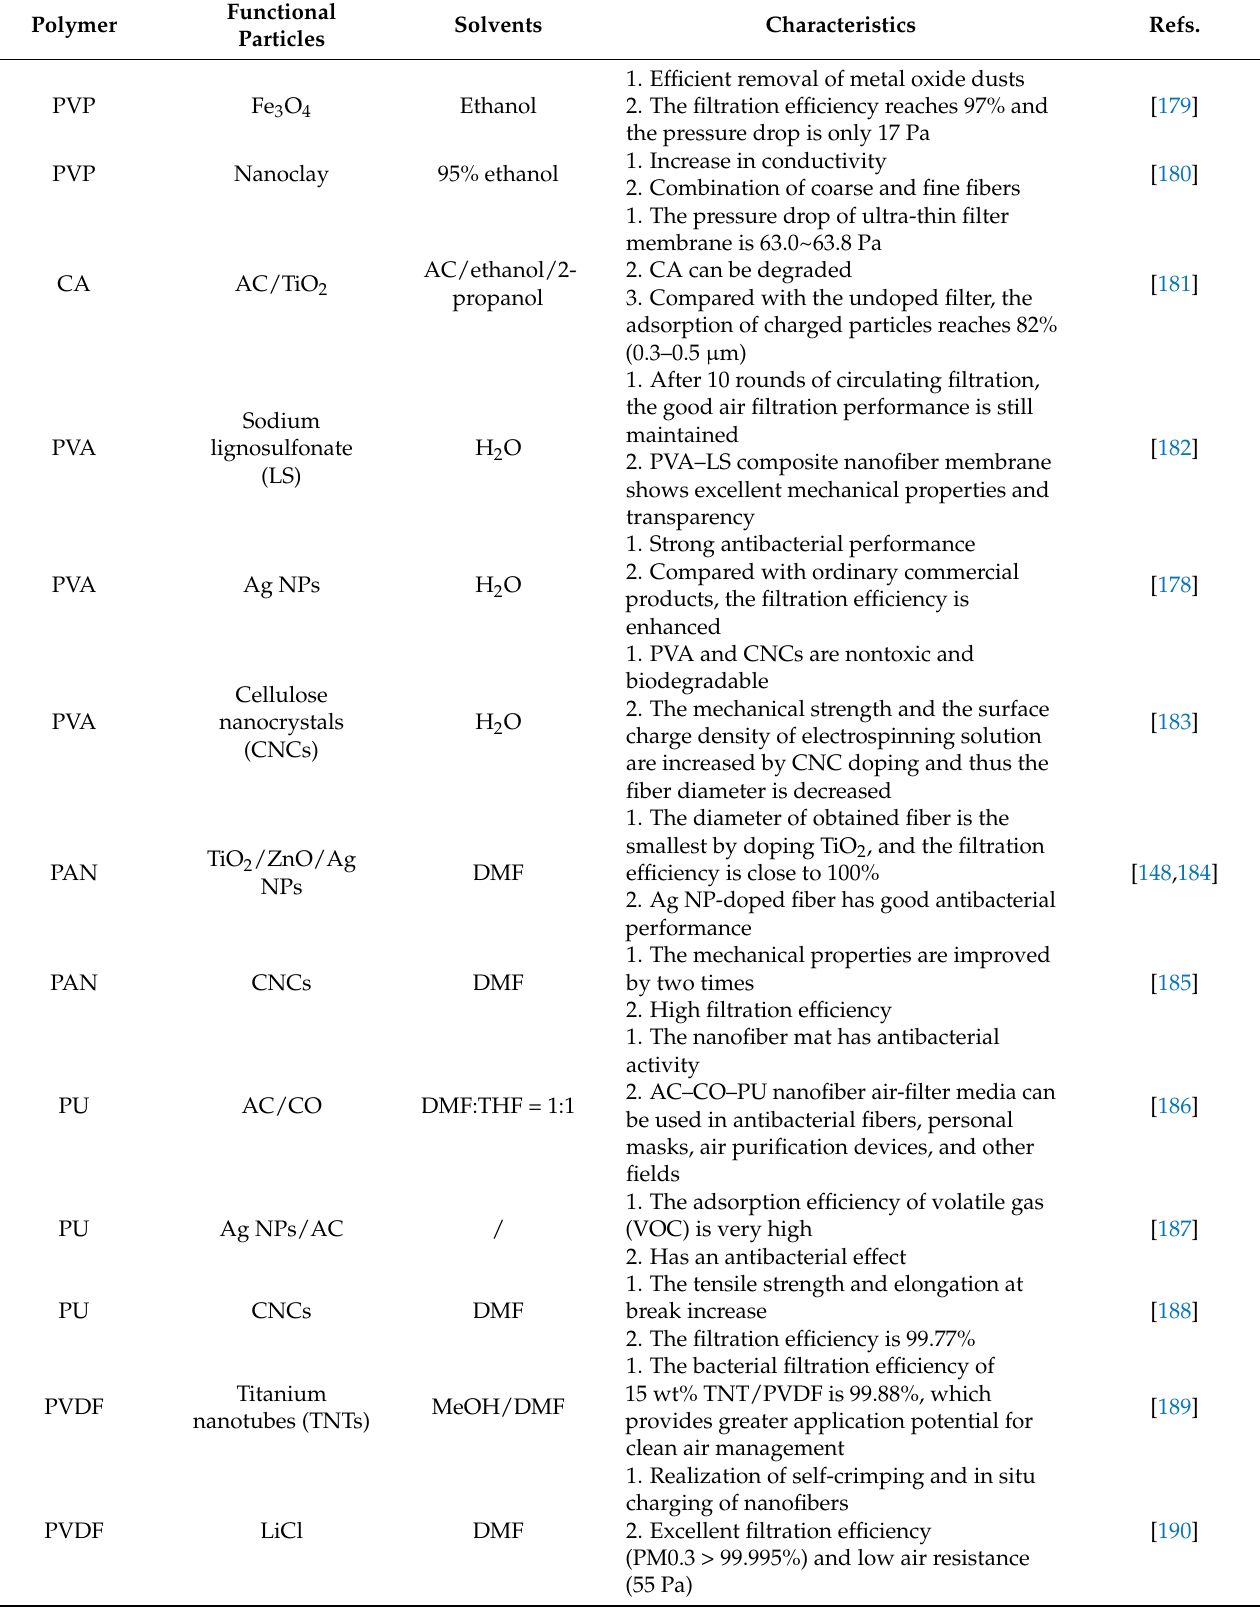
Table 4. Electrospun filter materials doped with functional